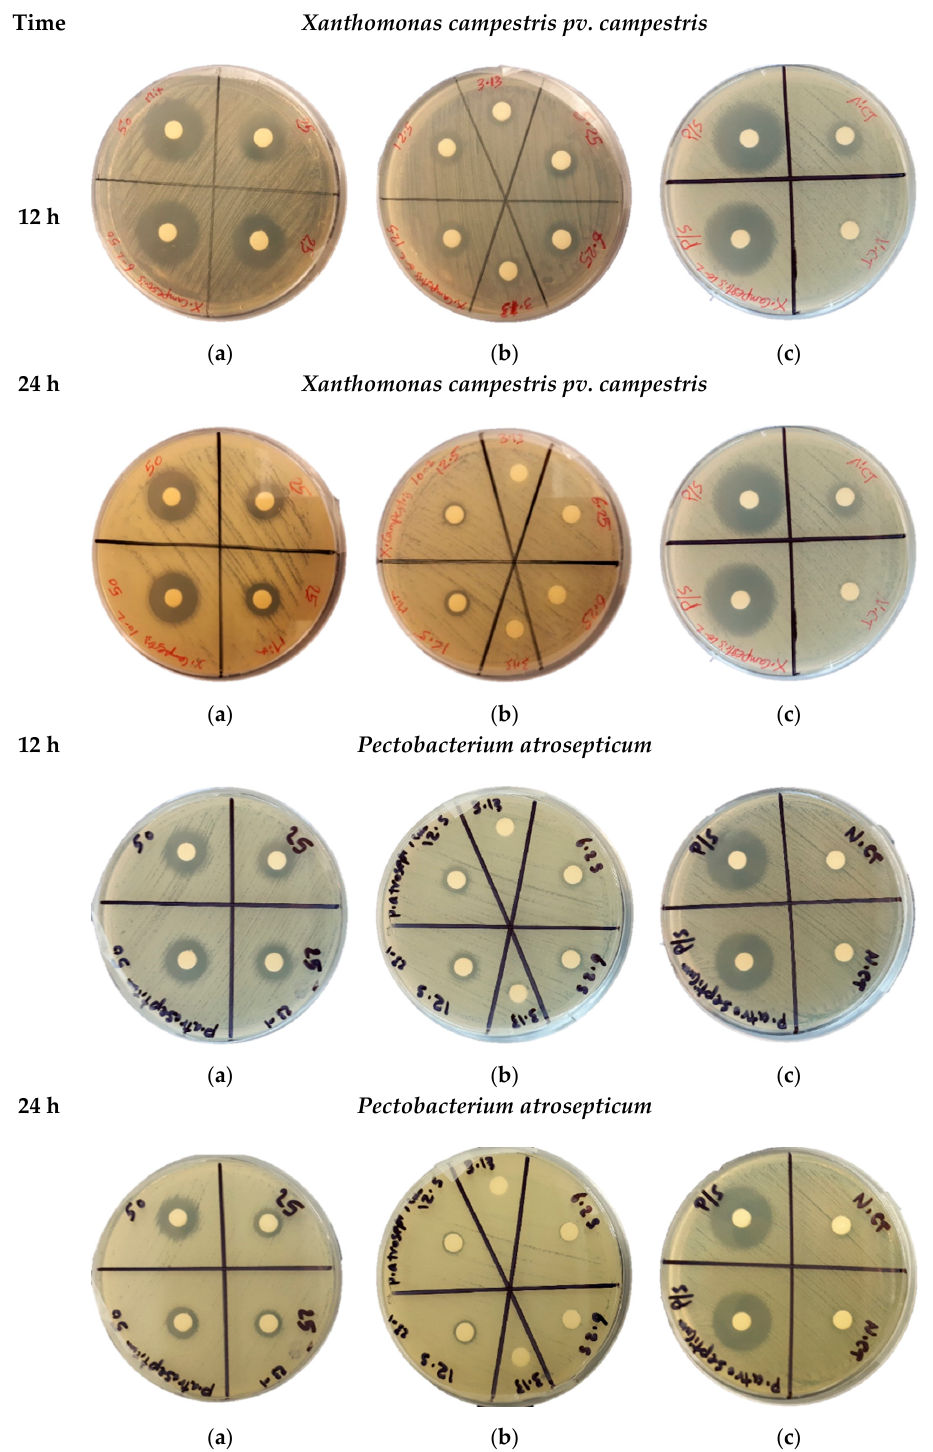
Figure 1. The bacterial growth inhibition assay. The representative images of zones of bacterial growth inhibition were measured after 12 h and 24 h of overnight incubation of the discs loaded on petri dishes agar with Xanthomonas campestris pv campestris and Pectobacterium atrosepticum bacteria lawn. The discs with tested samples were loaded with 50 µ L of AWME from larvae fat with concentrations of 50 and 25 mg / mL ( a ); 12.5, 6.25, and 3.13 mg / mL ( b ); 50 µ L of P / S samples with concentration 5000 U / mL–5000 µ g / mL was used as positive control ( c ). The 50 µ L of pure AWM extracting solution used as a negative control (N-CT) ( c ). All samples were loaded in